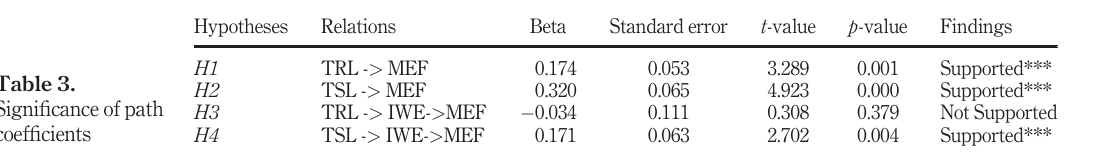
Table 3. Signi fi cance of path coef fi